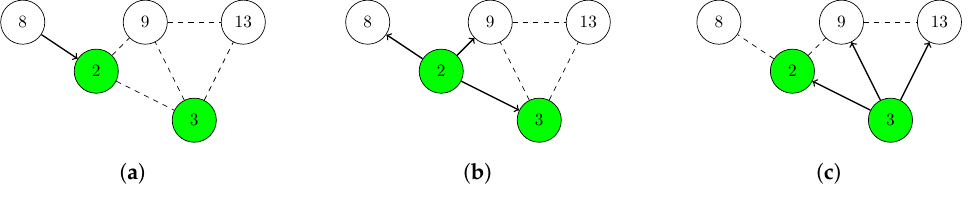
Figure 2. Using a CDS for network flooding. Nodes which are in the CDS are colored in green. The dashed lines indicate that two nodes are in transmission range of each other. Arrows show a transmission from one node to another one. ( a ) Node 8 broadcasts a packet to node 2. ( b ) Since node 2 is in the CDS, it rebroadcasts the packet to node 3, 8, and 9. ( c ) Since node 3 is in the CDS, it rebroadcasts the packet to node 2, 9, and 13. However, because node 8 and 9 are not in the CDS, they do not rebroadcast the